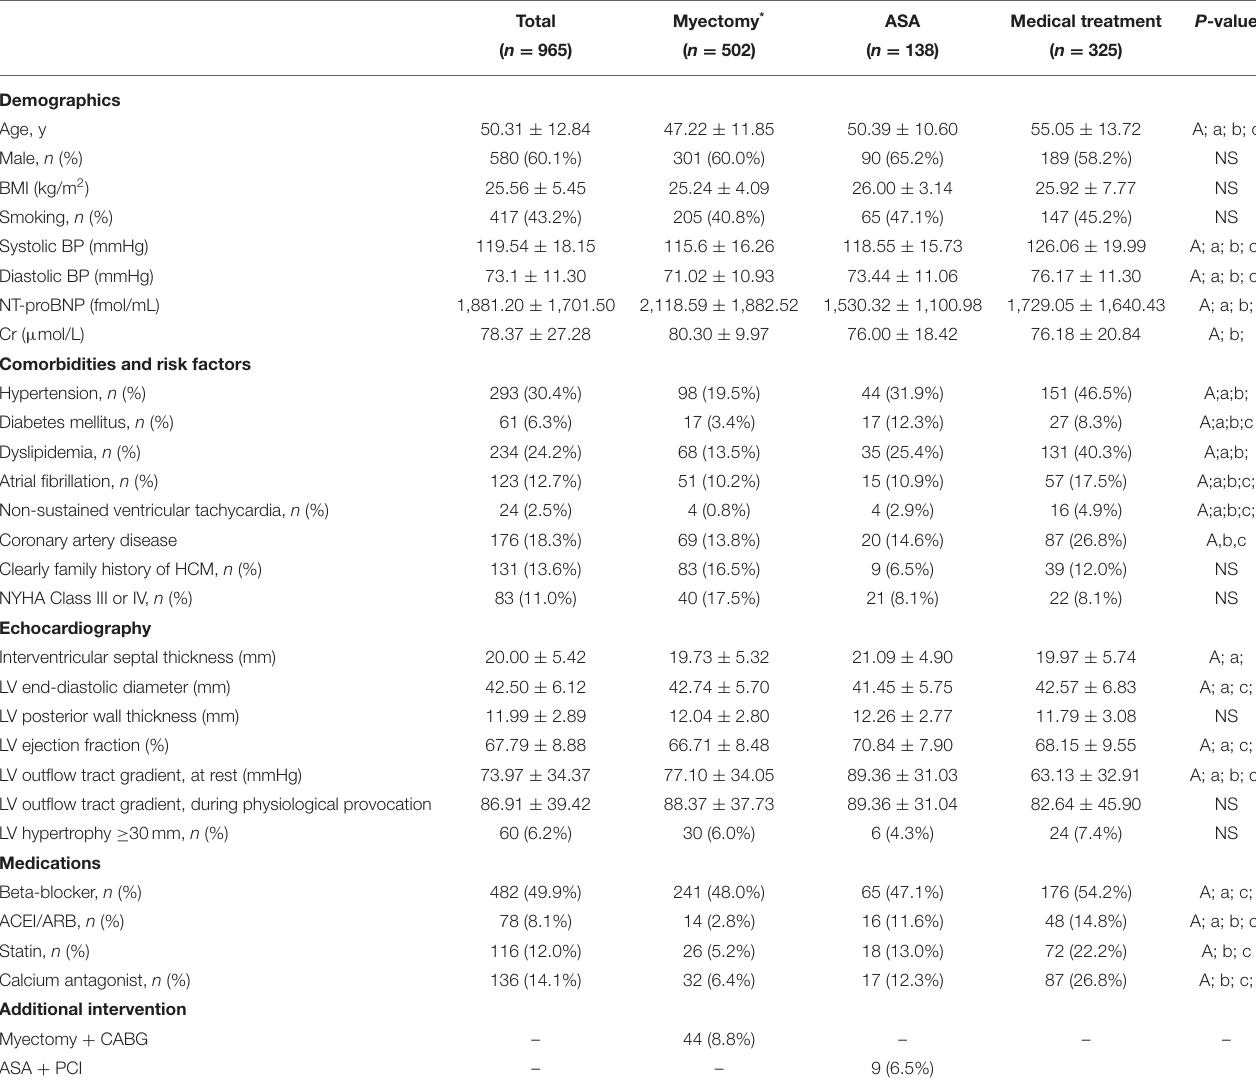
TABLE 1 | Baseline clinical